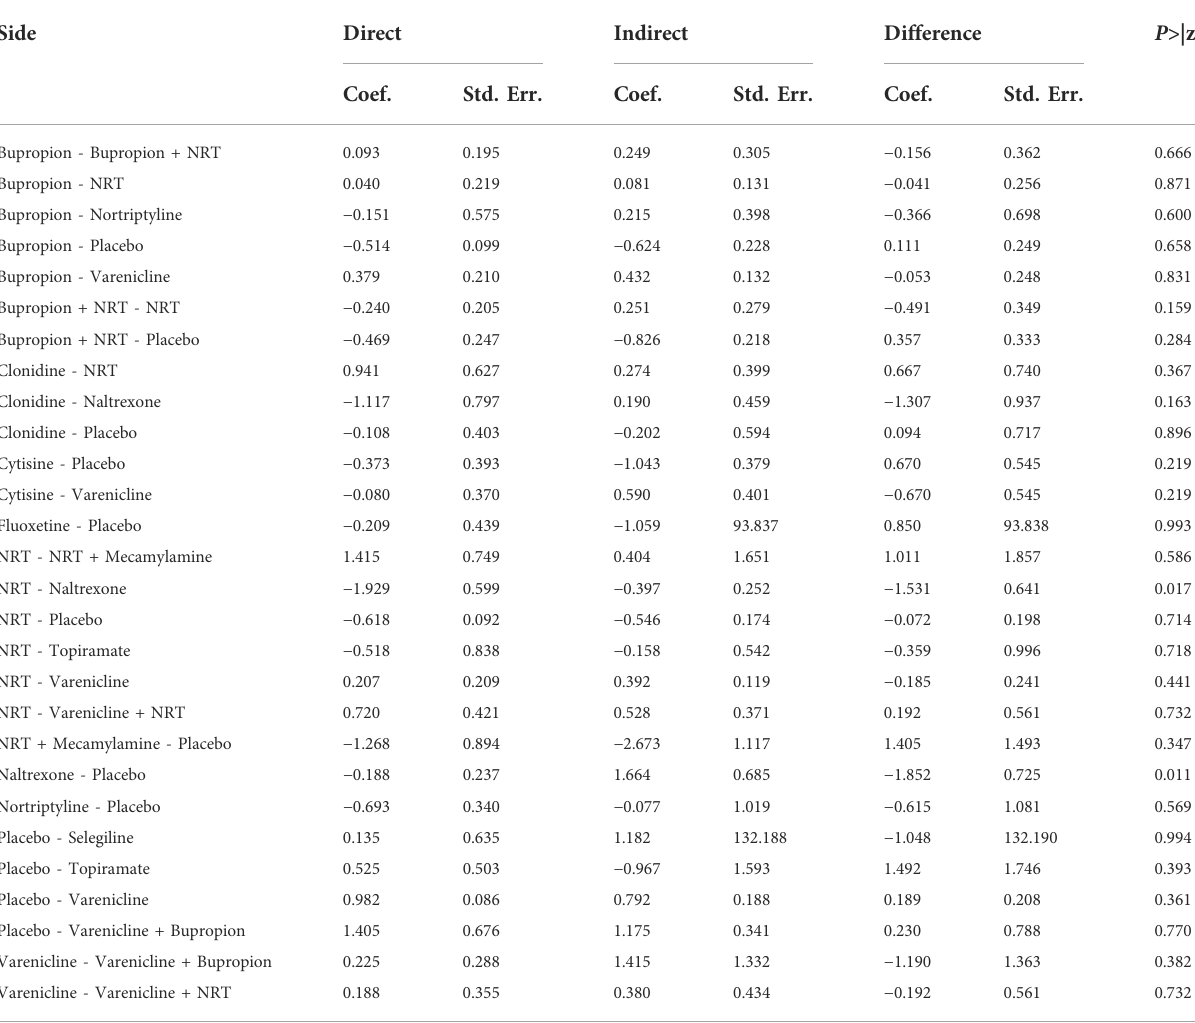
TABLE 1 Local inconsistency test based on